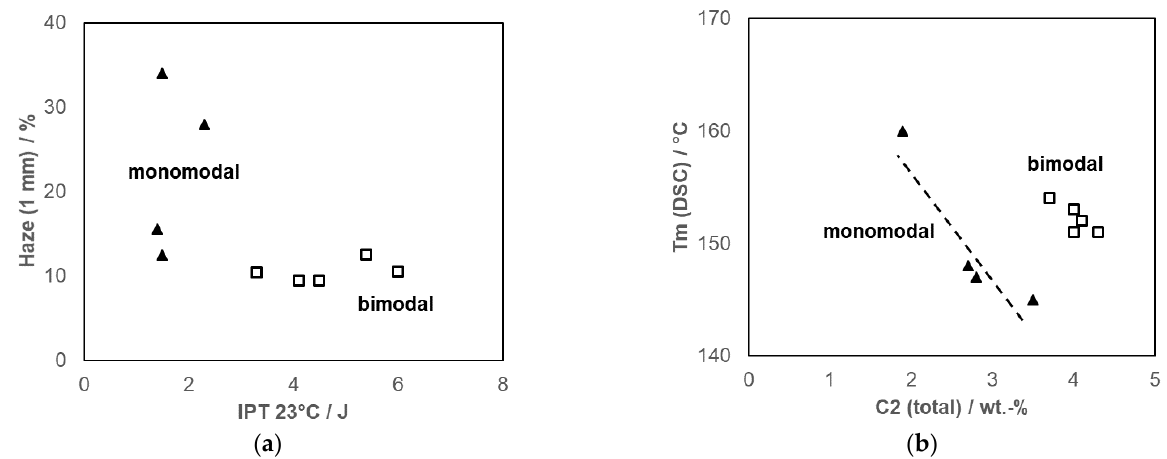
Figure 10. Comparison of high-flow mono- and bimodal C2C3 random copolymers: ( a ) balance between toughness (total energy from instrumented puncture test) and haze, and ( b ) correlation between total C2 content and melting point (data from [87] and commercial references).